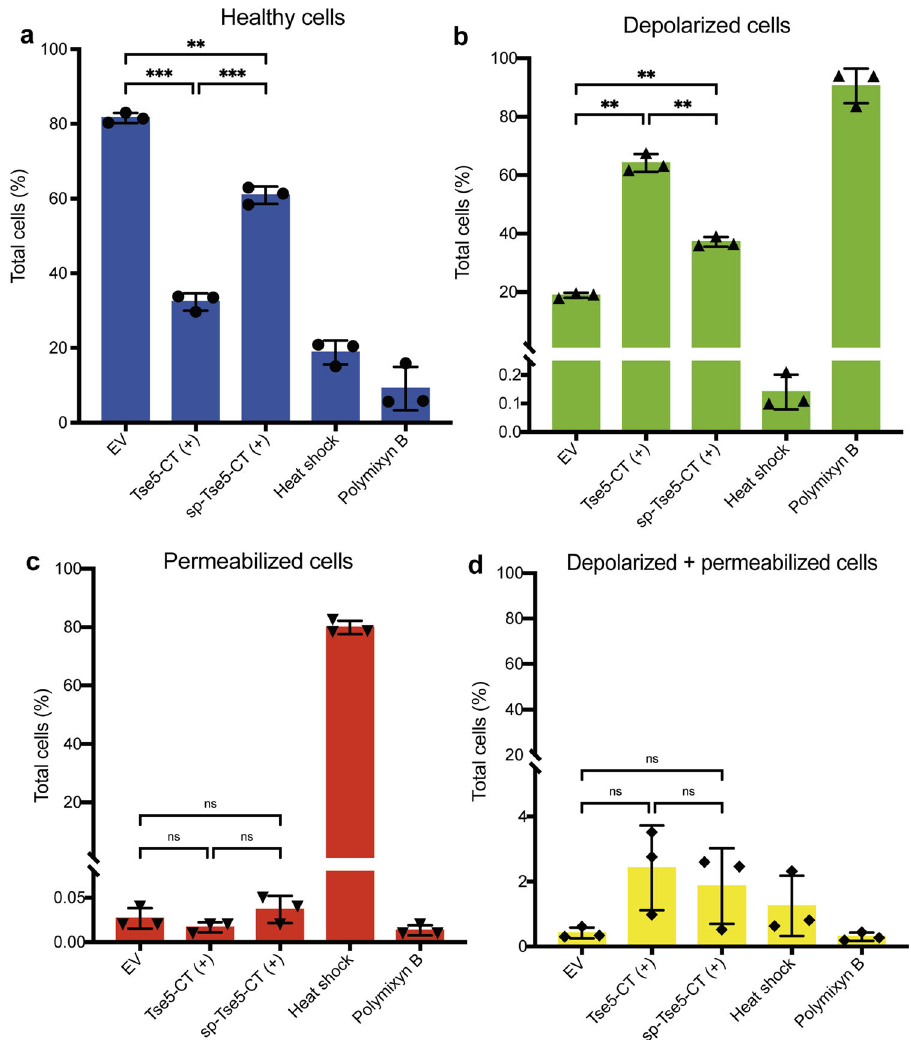
Fig. 2 Tse5-CT causes membrane depolarisation when expressed in P. putida . Flow cytometry experiments were performed with P. putida cells harbouring pS238D1 empty vector (EV) as a negative control and plasmids directing the expression of Tse5-CT or sp-Tse5-CT. Each graph includes two positive controls: cells treated with a heat shock that results in cell permeabilization and cells treated with polymyxin B, which results in cell depolarisation. a Flow cytometry results showing healthy cell populations. Healthy cells are not marked by any fl uorophore. b Flow cytometry data show depolarised cell populations. Depolarised cells are stained with DiBAC 4 (3). c Flow cytometry results show permeabilized cell populations. Permeabilized cells are stained with Sytox ™ Deep Red. d Flow cytometry results show permeabilized and depolarised cell populations. All measurements were made in triplicate ( n = 3 biological replicates). The graphs show the mean values and ±standard deviations (SD). The one-way ANOVA (Brown – Forsythe ANOVA test) with Dunnett´s T3 multiple comparisons test was used to determine whether there is a signi fi cant difference between the mean values of our independent groups (non-signi fi cant [ns] if p > 0.05, * if p ≤ 0.05, ** if p ≤ 0.01, *** if p ≤